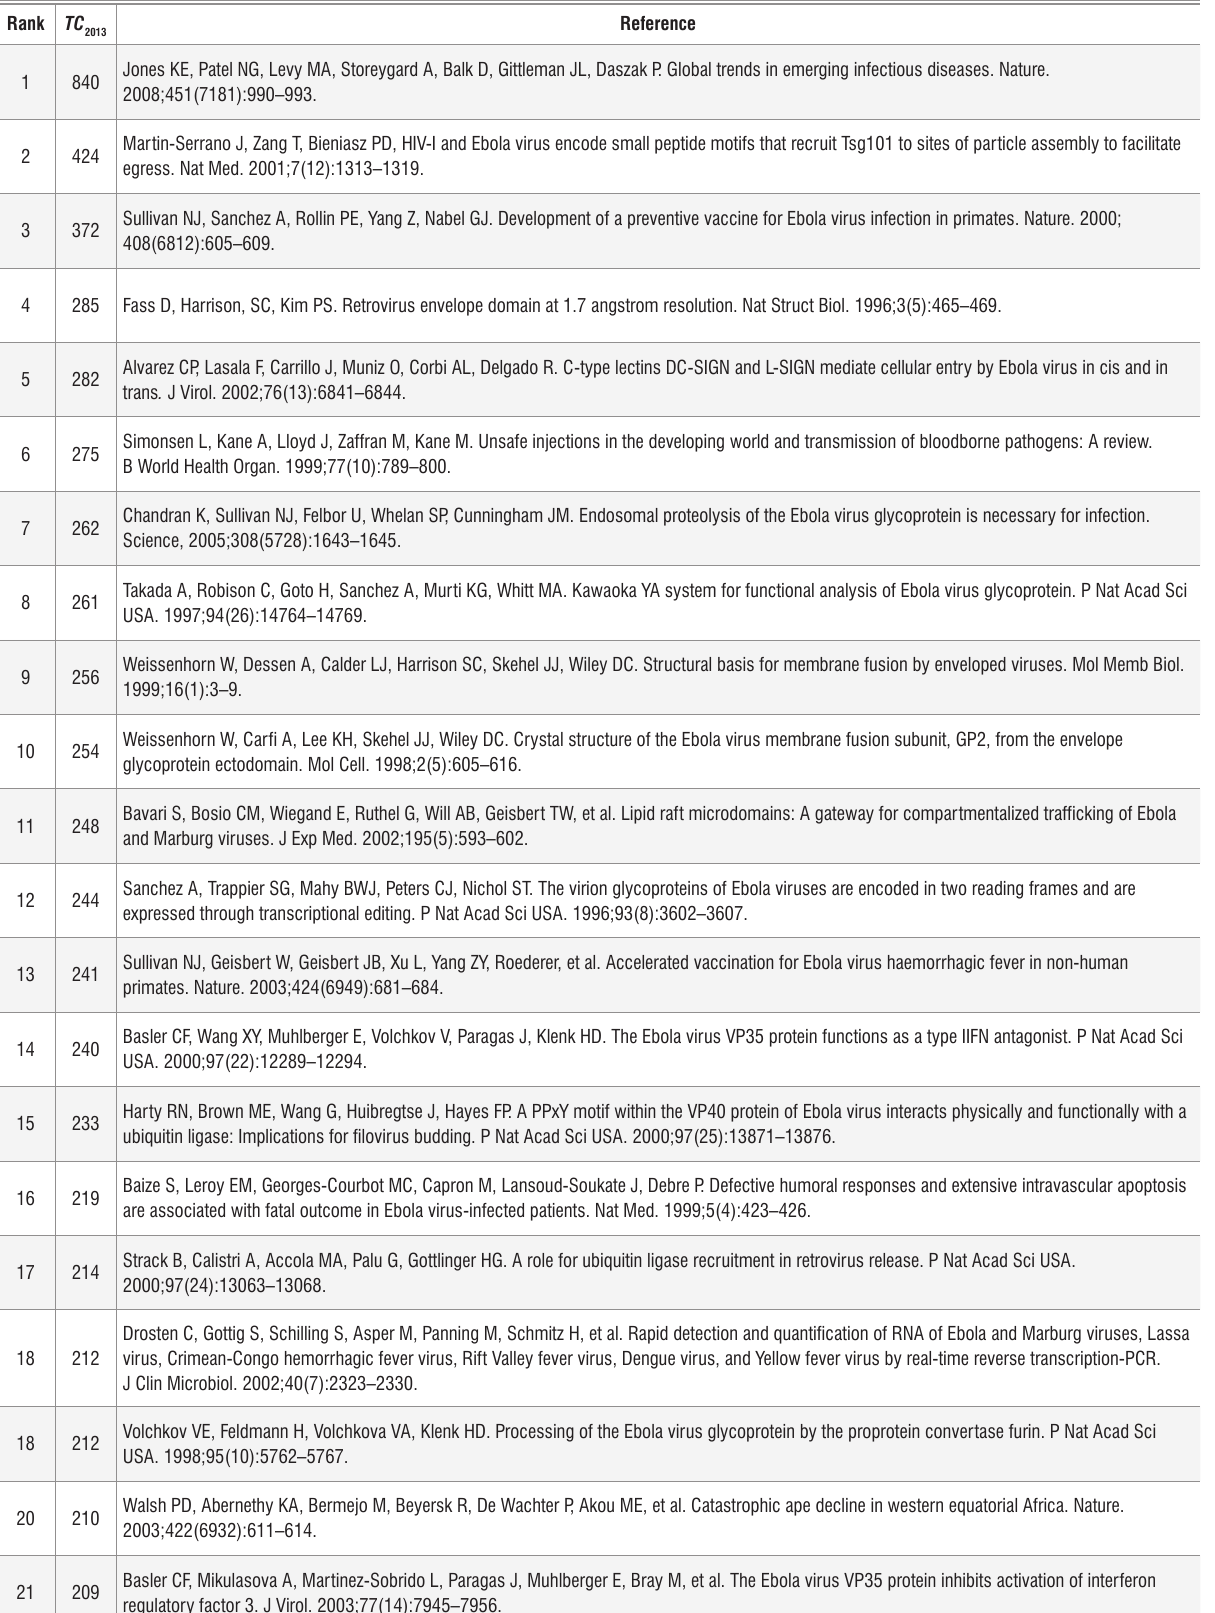
Table 3: Top 21 most cited articles ( TC